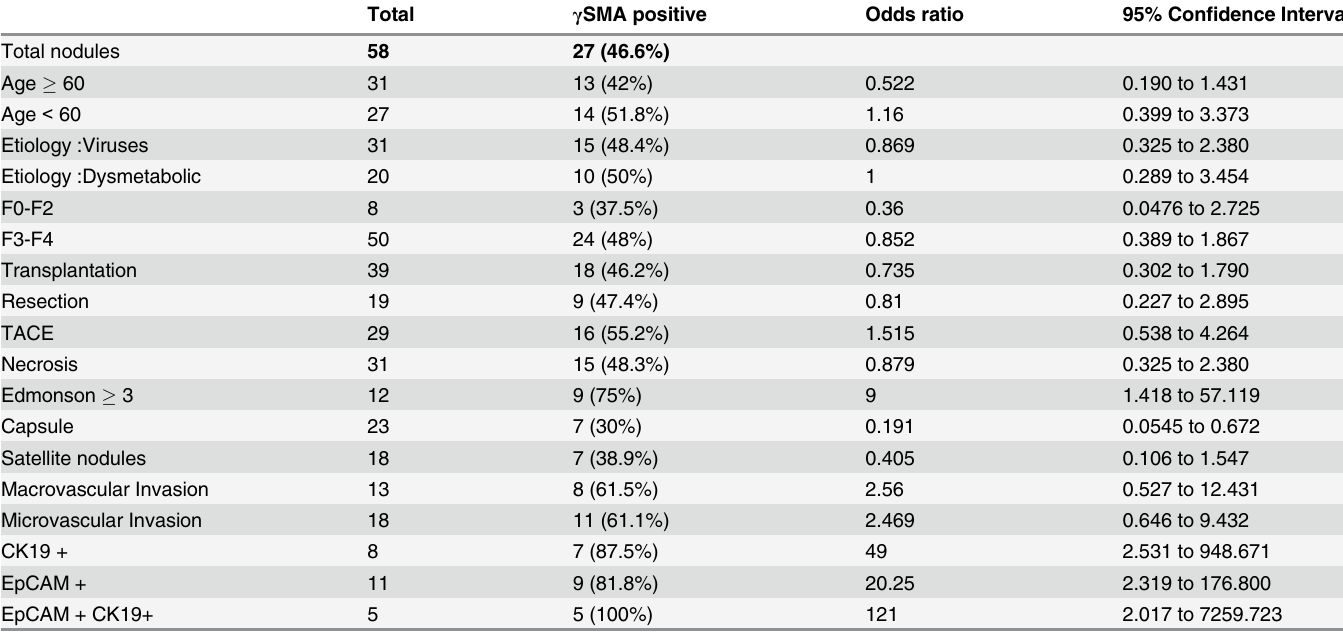
Table 1. Correlation between γ SMA expression, clinicopathological parameters and progenitor markers in